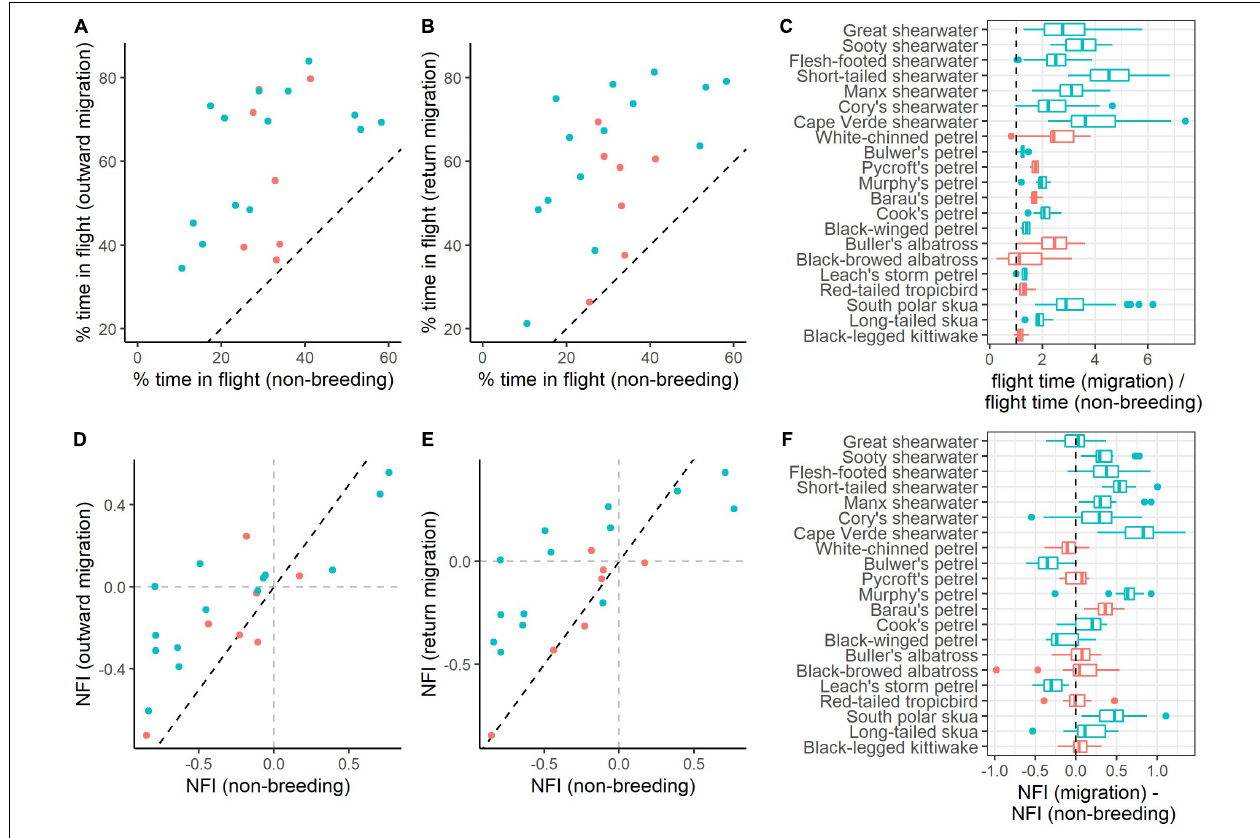
FIGURE 2 | Behavioural adaptations to migration, contrasted between transequatorial (blue) and other (pink) migrants. (A,B) Relationship between flight time during migration and the non-breeding period, for outward and return migration, respectively. (C) Ratio of % flight time during migration over % of flight time during the non-breeding period (boxplots of mean values for each individual across seasons). Species above the dotted line in panels (A,B) or individuals right of the dotted line in panel (C) spend more time in flight during migration than during the non-breeding period. (D,E) Relationship between nocturnality levels during migration and winter. (F) Difference between NFI during migration and winter (boxplots of mean values for each individual across seasons). Species above the dotted line in panels (D , E) or individuals right of the dotted line in panel (F) are more nocturnal during migration than during the non-breeding period. (A,D) outward migration; (B,E) return